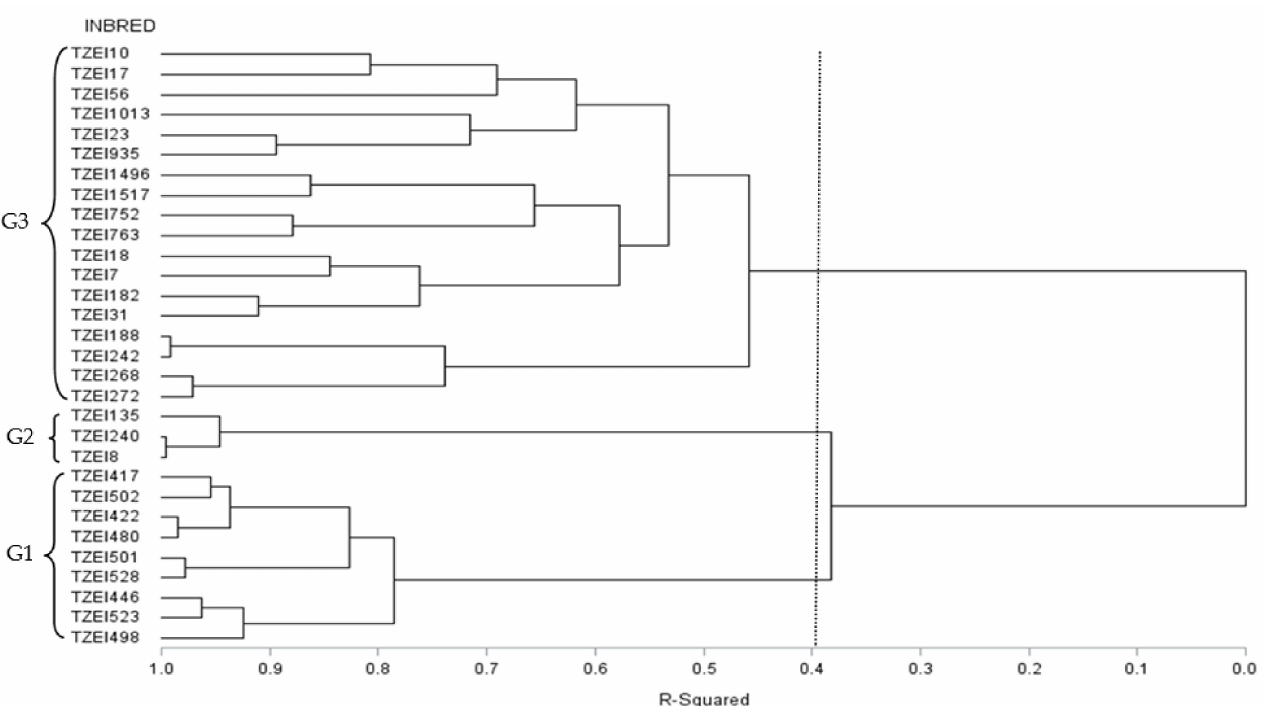
Figure 3. Dendrogram of 30 early-maturing maize inbred lines generated using cluster analysis of Euclidean genetic distance matrix obtained from Diversity Array Technology sequencing (DArTseq) markers. The imagery line indicates cut off point at 40% level of dissimilarity (R 2 =